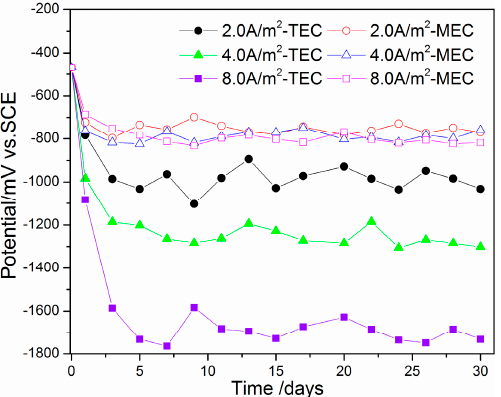
Figure 3. Change of steel potential with time during the TEC treatment and the MEC treatment. SCE: saturated calomel electrode.